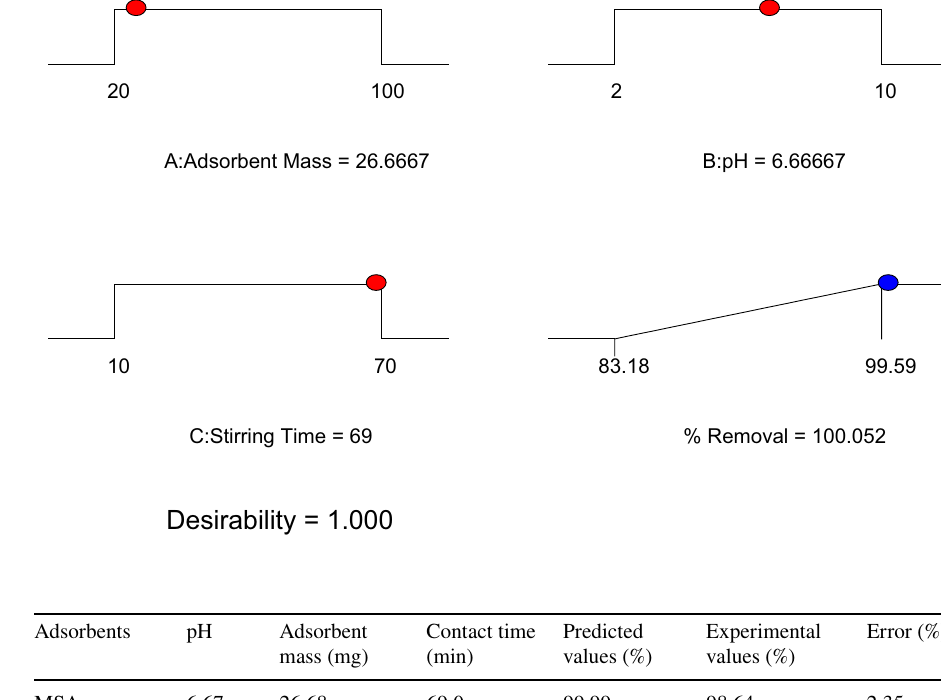
Fig. 17 Desirability ramp of optimization using MSA